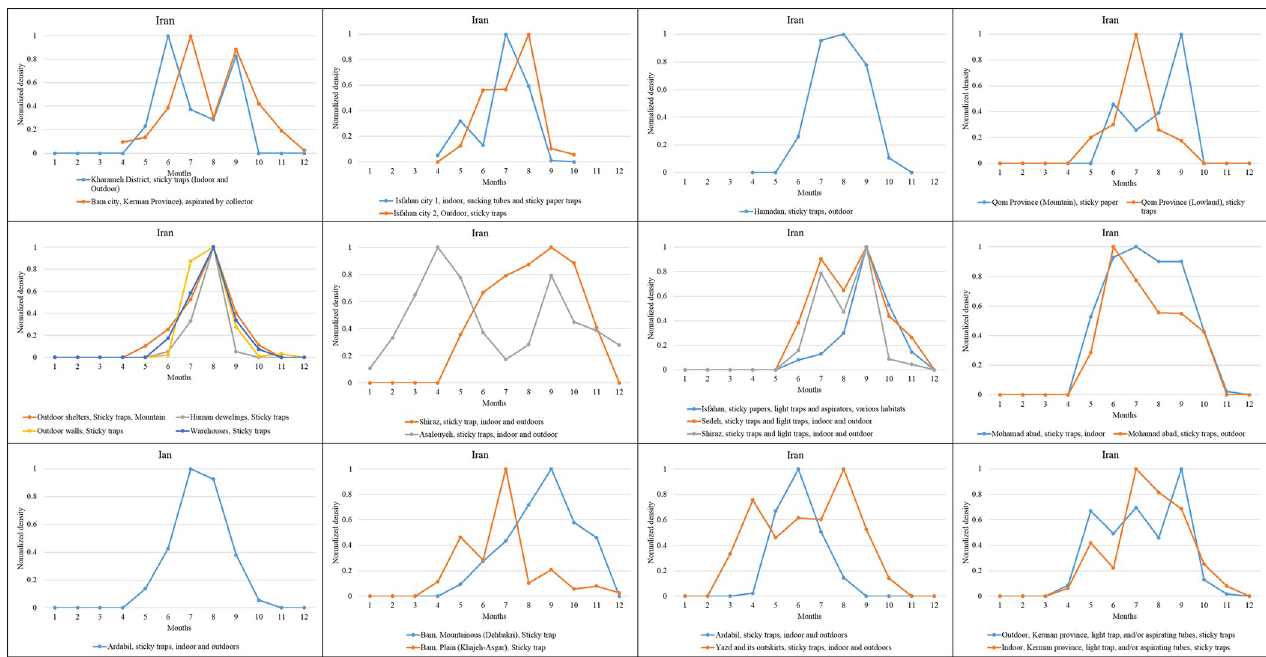
Fig 8. The seasonal density of P . (Par . ) sergenti (normalized values) was extracted from data collected for Iran.